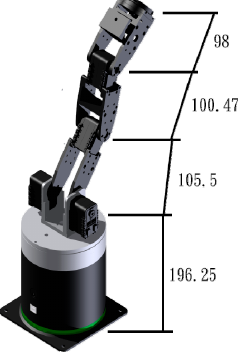
Figure 1. The 6-axis robotic arm used in the study (unit: mm).